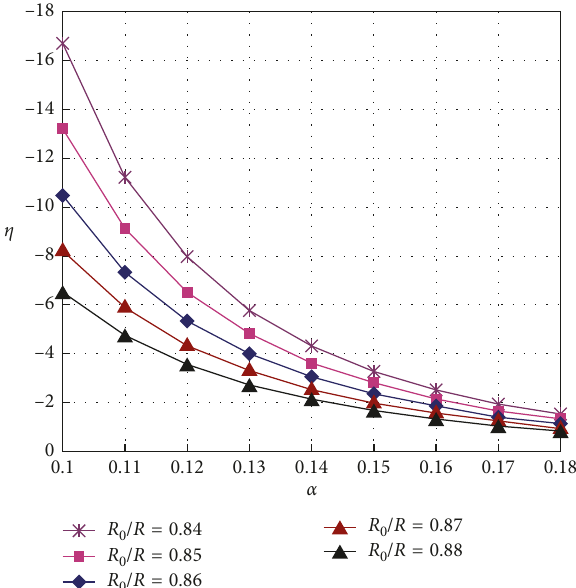
Figure 5: The effect of α on the plastic limit load with different values of R 0 /R